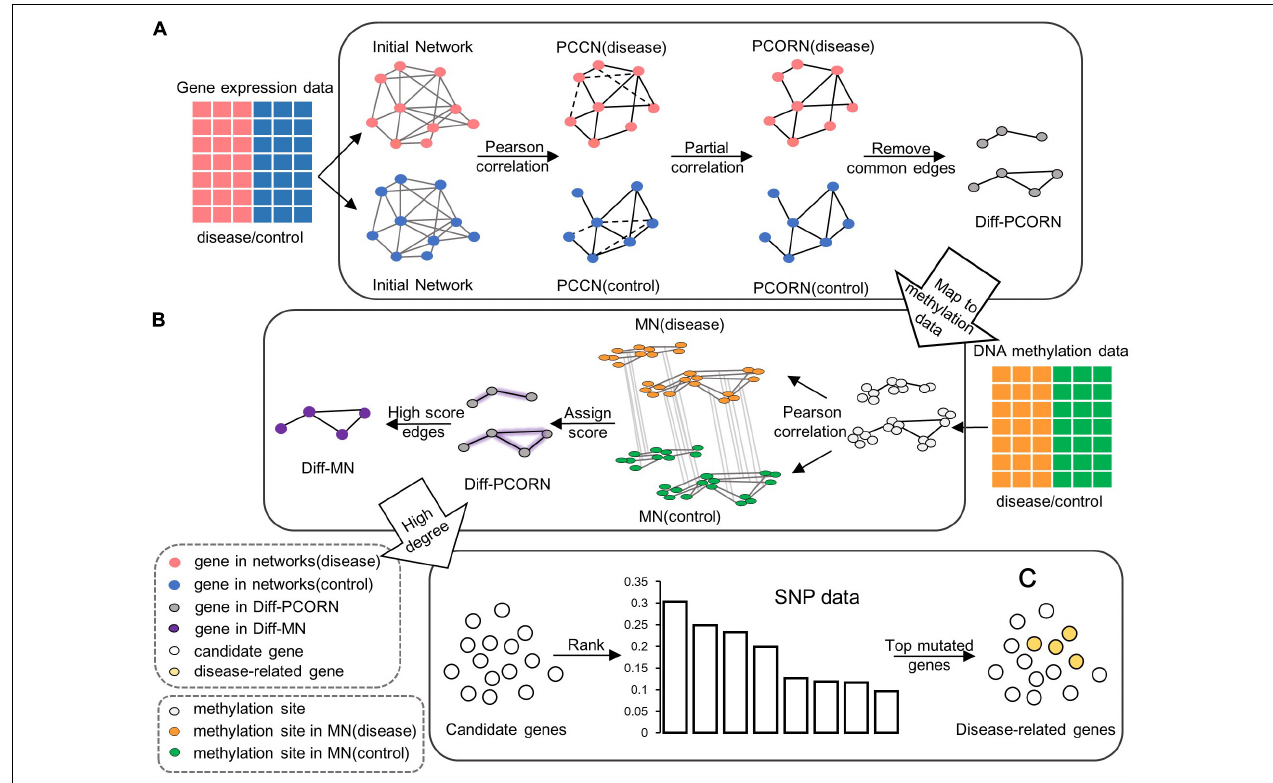
FIGURE 1 | The flowchart for data integration. (A) Construction of differential partial correlation network (Diff-PCORN). After constructing the initial network based on the PPI network, the edges with a significant Pearson correlation are kept (adjusted p < 0.01) as the PCCN. Then, PCORN is constructed by deleting the non-significant edges (dotted line in PCCN) with adjusted p -values of partial correlation greater than or equal to 0.05. Remove edges in both PCORN (disease) and PCORN (control). (B) Construction of differential methylation network (Diff-MN). Pearson correlation coefficient can be calculated between methylation sites if there are interactions between their corresponding genes. Every edge is assigned a score by the maximum value of correlation difference between MN (disease) and MN (control). The edge with a score greater than 0.7 forms the Diff-MN. (C) Rank the candidate genes according to the variation frequency and the top 15 genes are identified as potential disease-related genes or module